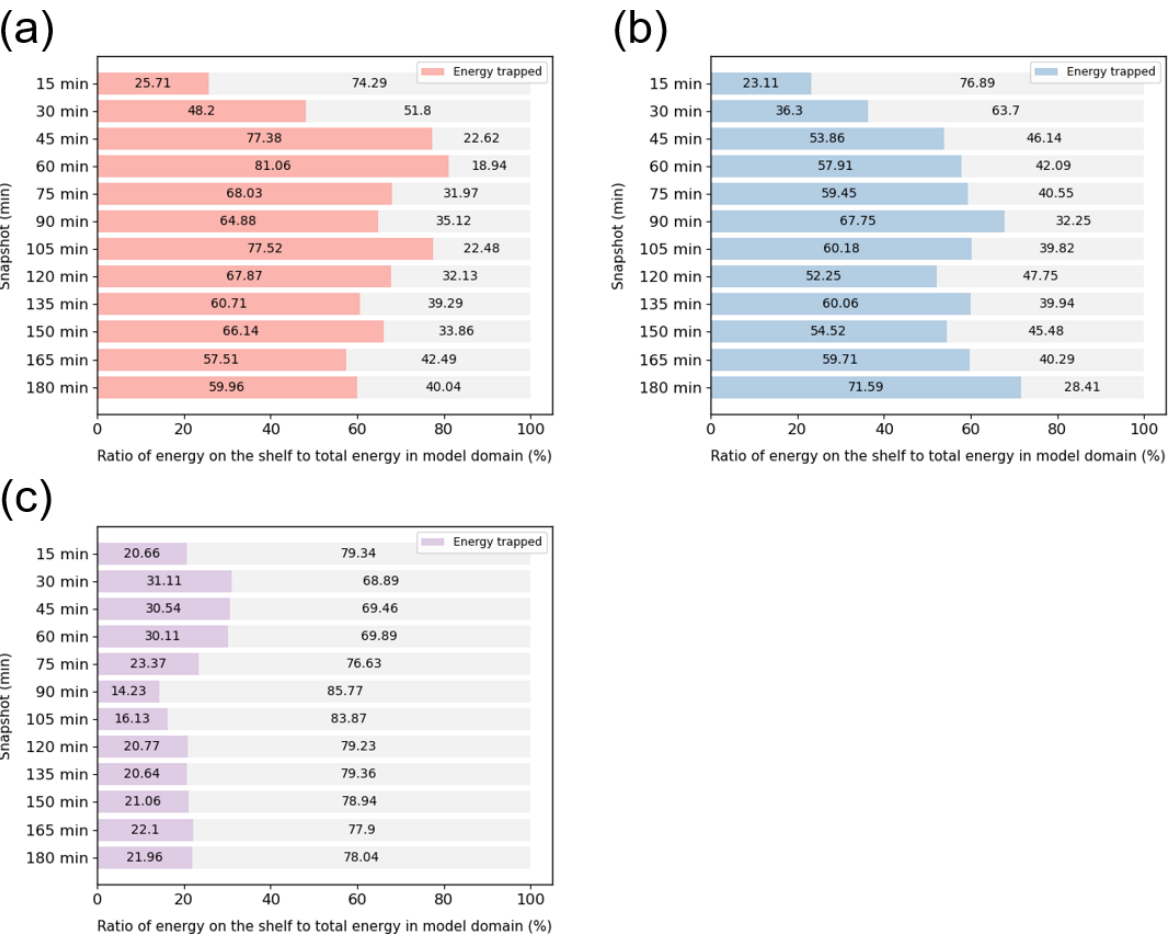
Figure 24. Trapped ratio calculated from tsunami propagation snapshots every 15min from numerical experiments (a) MS, (b) EXP1, and (c)